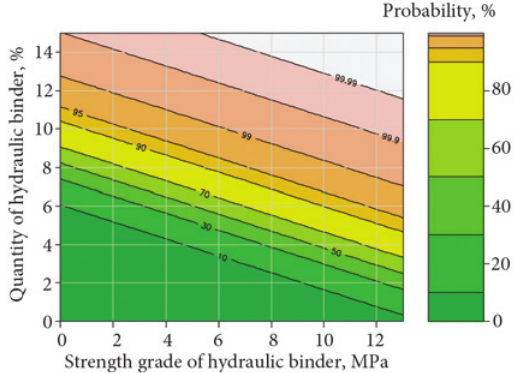
Fig. 3. Contour map of probability of conformity of the compressive strength condition by a soil-binder mixture made from soil No. 1 tested after 42 days (2.5 MPa ≤ R c 42 ≤ 5.0 MPa), without consideration of the frost resistance coefficient n ( n = 0)